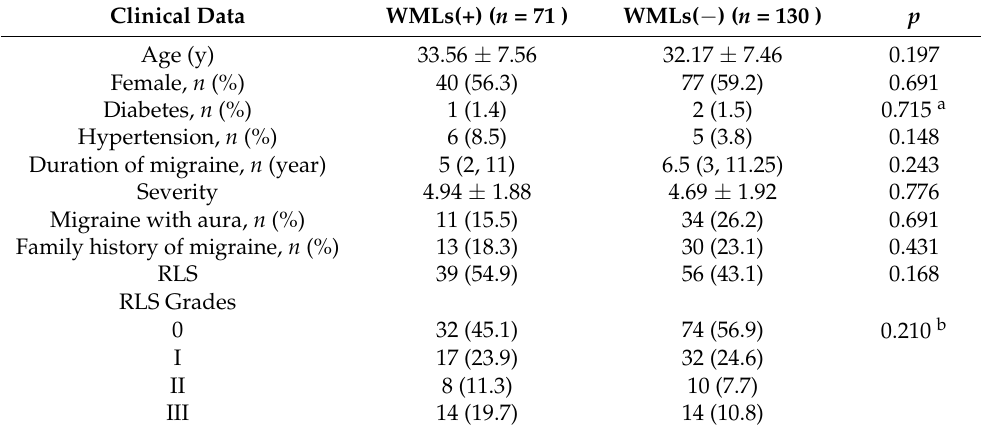
Table 1. Comparison of characteristics between the WML-positive and WML-negative groups.